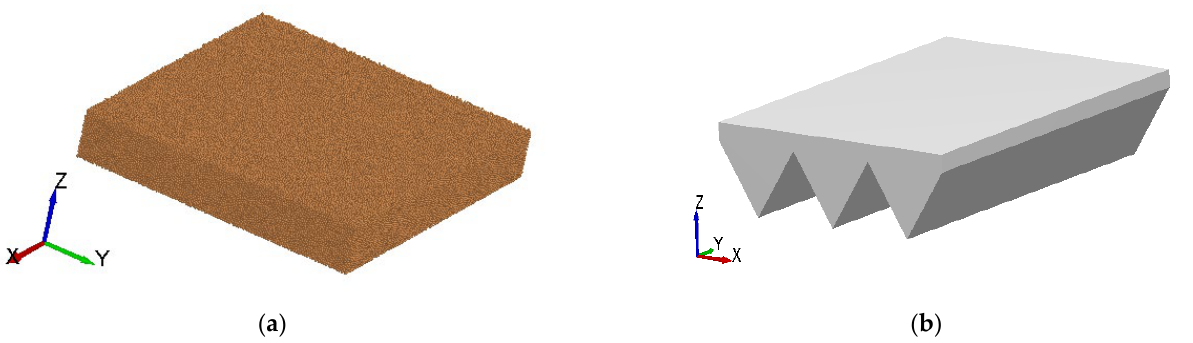
Figure 8. The virtual model of the soil bin and track segment. ( a ) DEM soil bin model with scaled-up particles. ( b ) Virtual track segment model (80 mm length, 60 mm width and 12 mm grouser height).